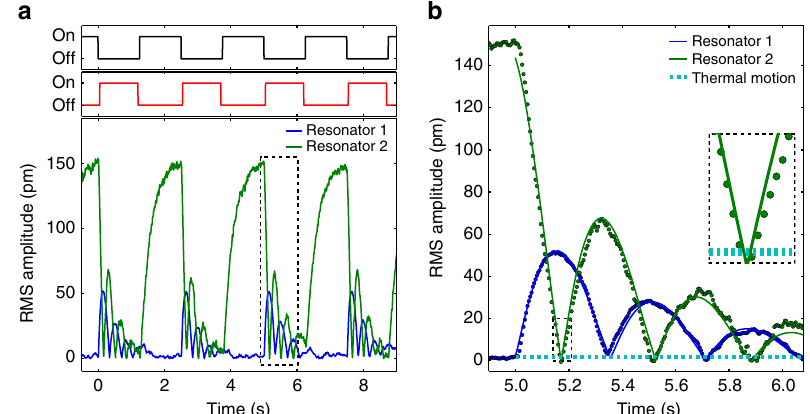
Fig. 3 Optomechanical swapping between mechanical resonators. a We alternate turning on a mechanical drive (black) and an optical swapping fi eld (red), while continuously measuring the root mean square (RMS) amplitude of motion of the two resonators. This single-shot measurement shows the repeatable dynamics of the system. b A single swapping interaction (the dashed box in a ) shows phonon Rabi oscillations. Solid lines are fi ts to the measured data points, and the dotted line indicates the thermal motion of the two resonators. Because the motion dips down to the thermal noise level every period, there is complete state swapping. The inset shows one such dip after a single complete state